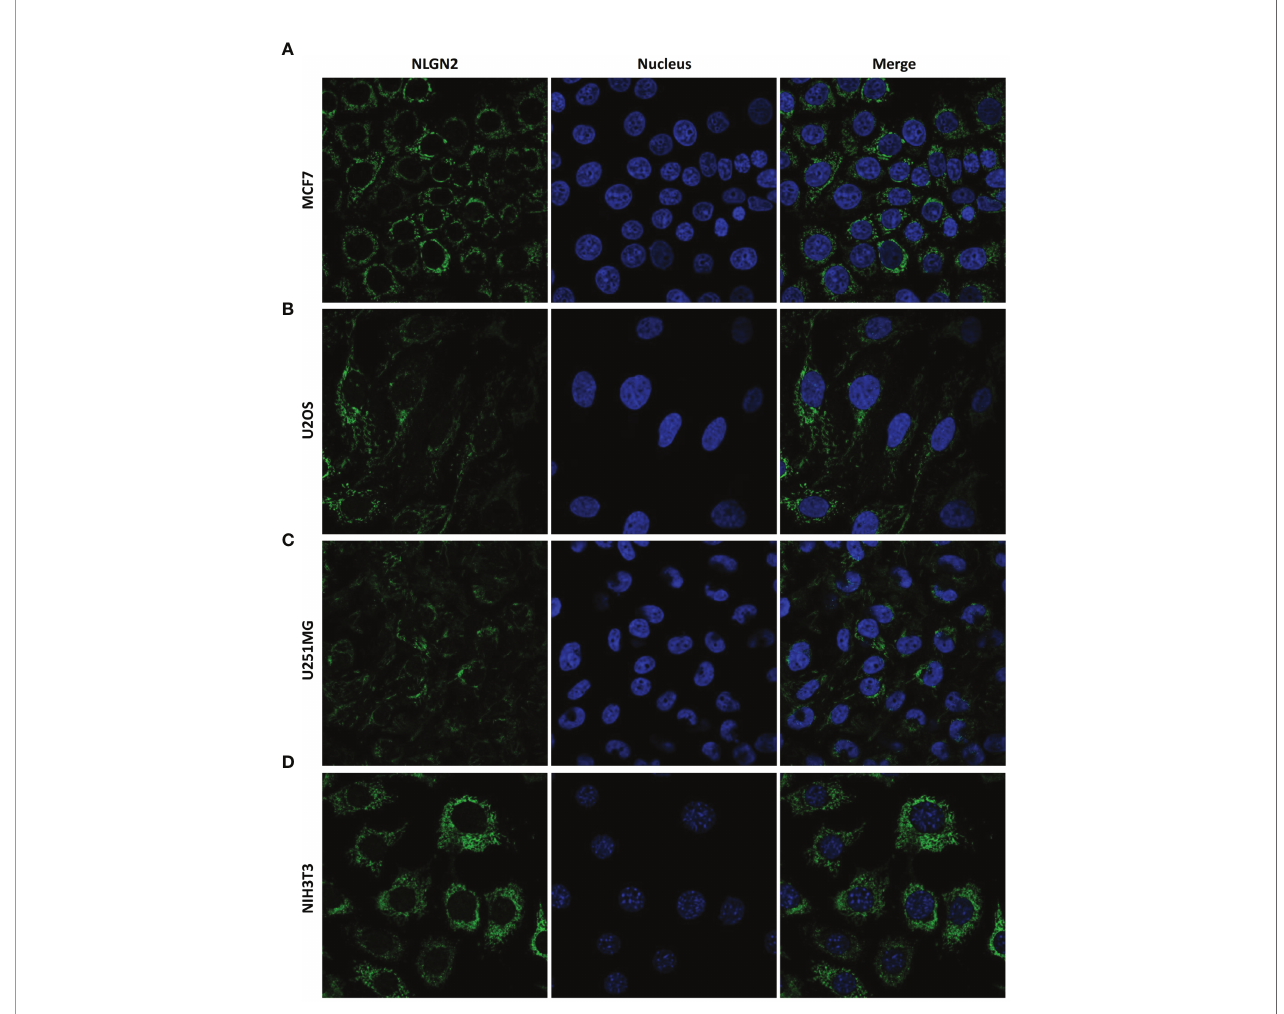
FIGURE 6 | NLGN2 is localized in the mitochondria of multiple cancer and normal cells. (A – D) Representative immuno fl uorescence images showing NLGN2 localization in (A) MCF7 breast adenocarcinoma cells, (B) U2OS osteosarcoma cells, (C) U251MG glioblastoma cells, and (D) NIH3T3 mouse embryonic fi broblast cells. Green: NLGN2; Blue: